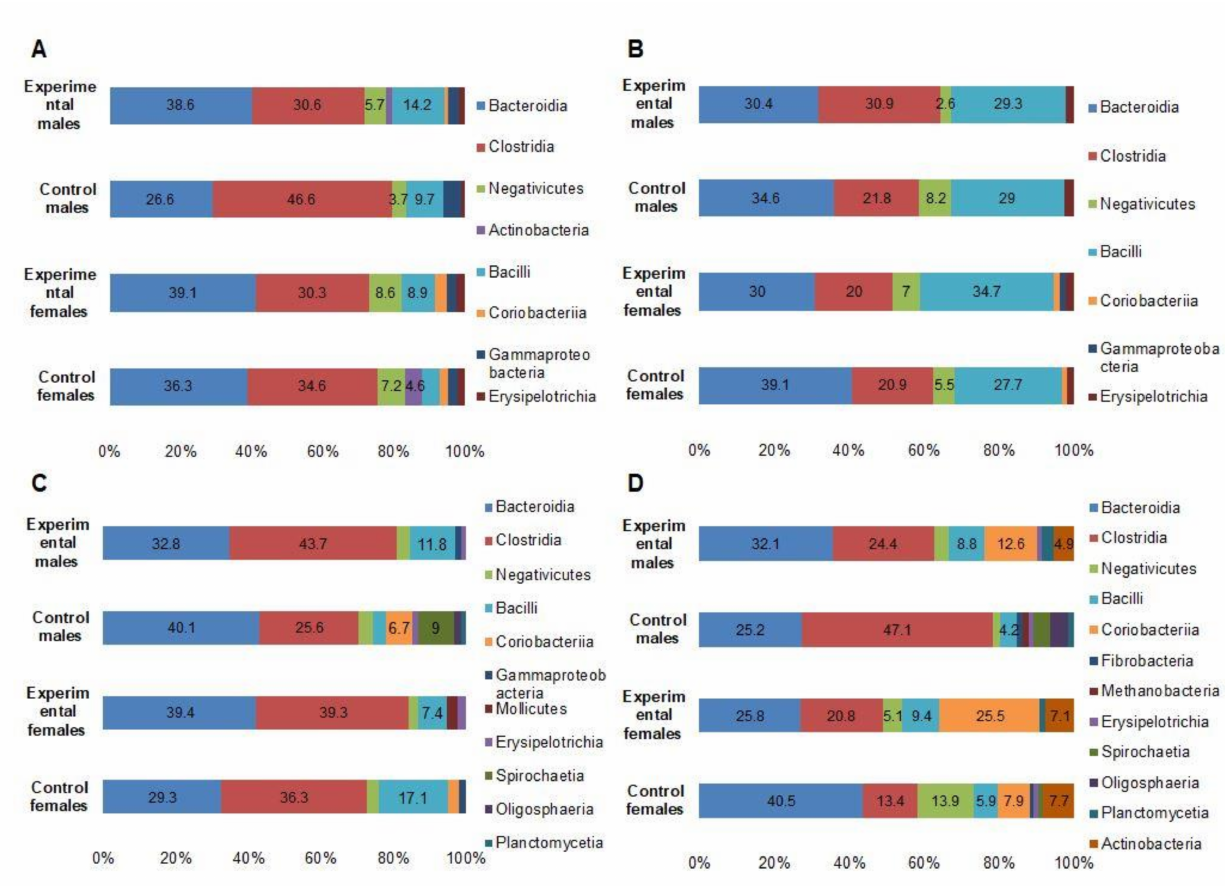
Figure 4. Bacterial classes in test animal and negative control group intestinal microbiota before ( A ), 7 days ( B ), 14 days ( C ) and 28 days ( D ) after supplementary